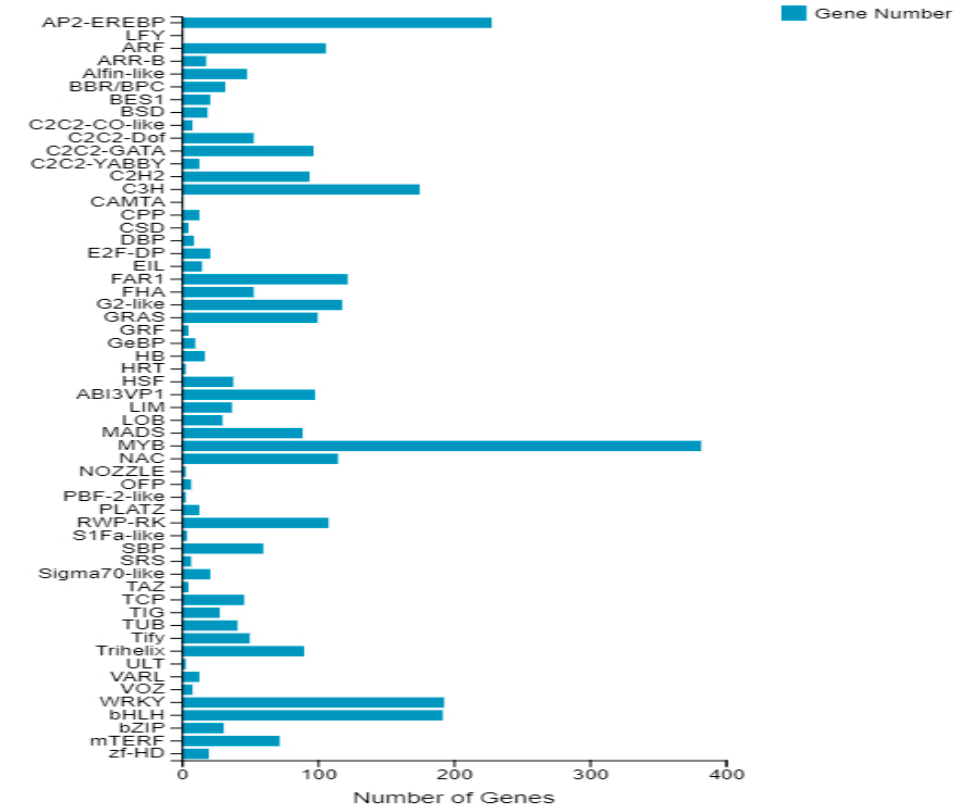
Figure 4. DEGs from every gene family involved transcription factors.